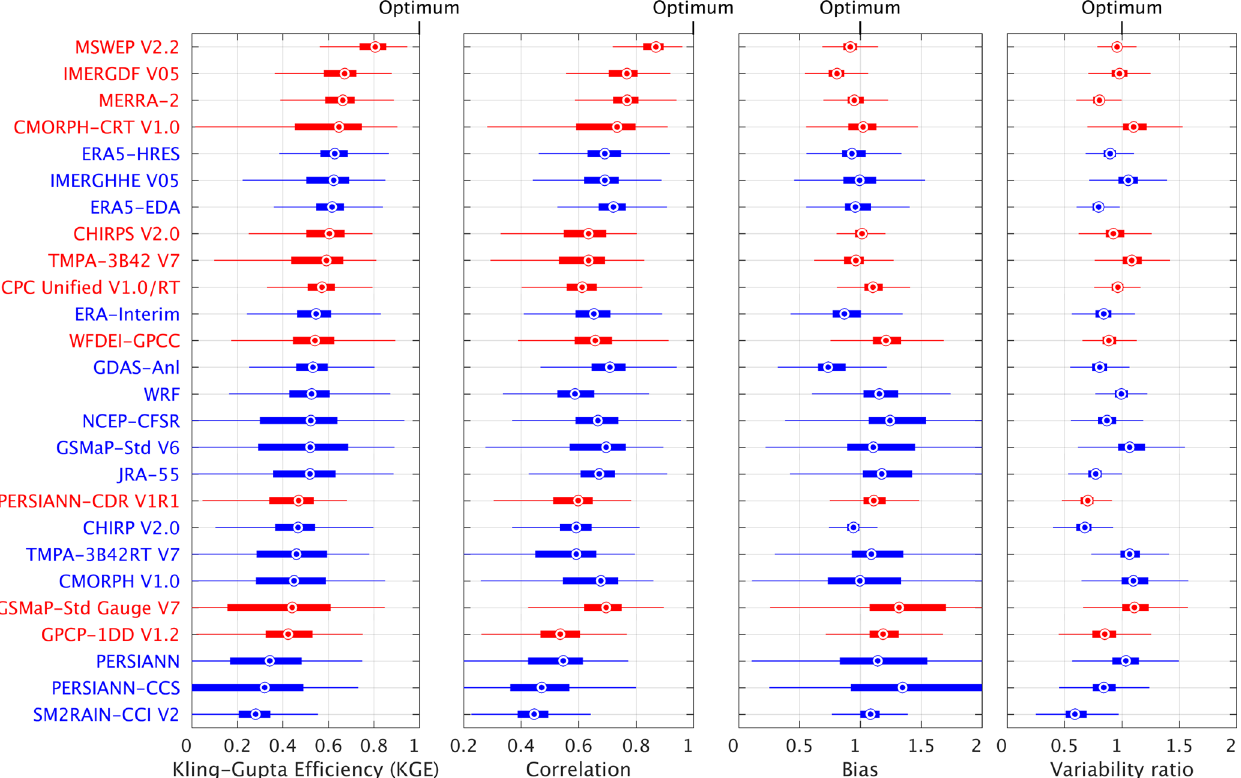
Figure 2. Box-and-whisker plots of KGE scores for the 26 gridded P datasets using the Stage-IV gauge-radar dataset as a reference. The circles represent the median value, the left and right edges of the box represent the 25th and 75th percentile values, respectively, while the “whiskers” represent the extreme values. The statistics were calculated for each dataset from the distribution of grid-cell KGE values (no area weighting was performed). The datasets are sorted in ascending order of the median KGE. Uncorrected datasets are indicated in blue, whereas gauge-corrected datasets are indicated in red. Details on the datasets are provided in Tables 1 and